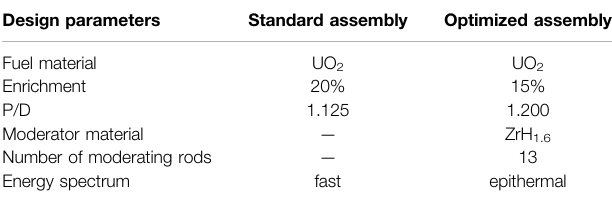
TABLE 9 | Comparison of the standard assembly an optimized assembly.